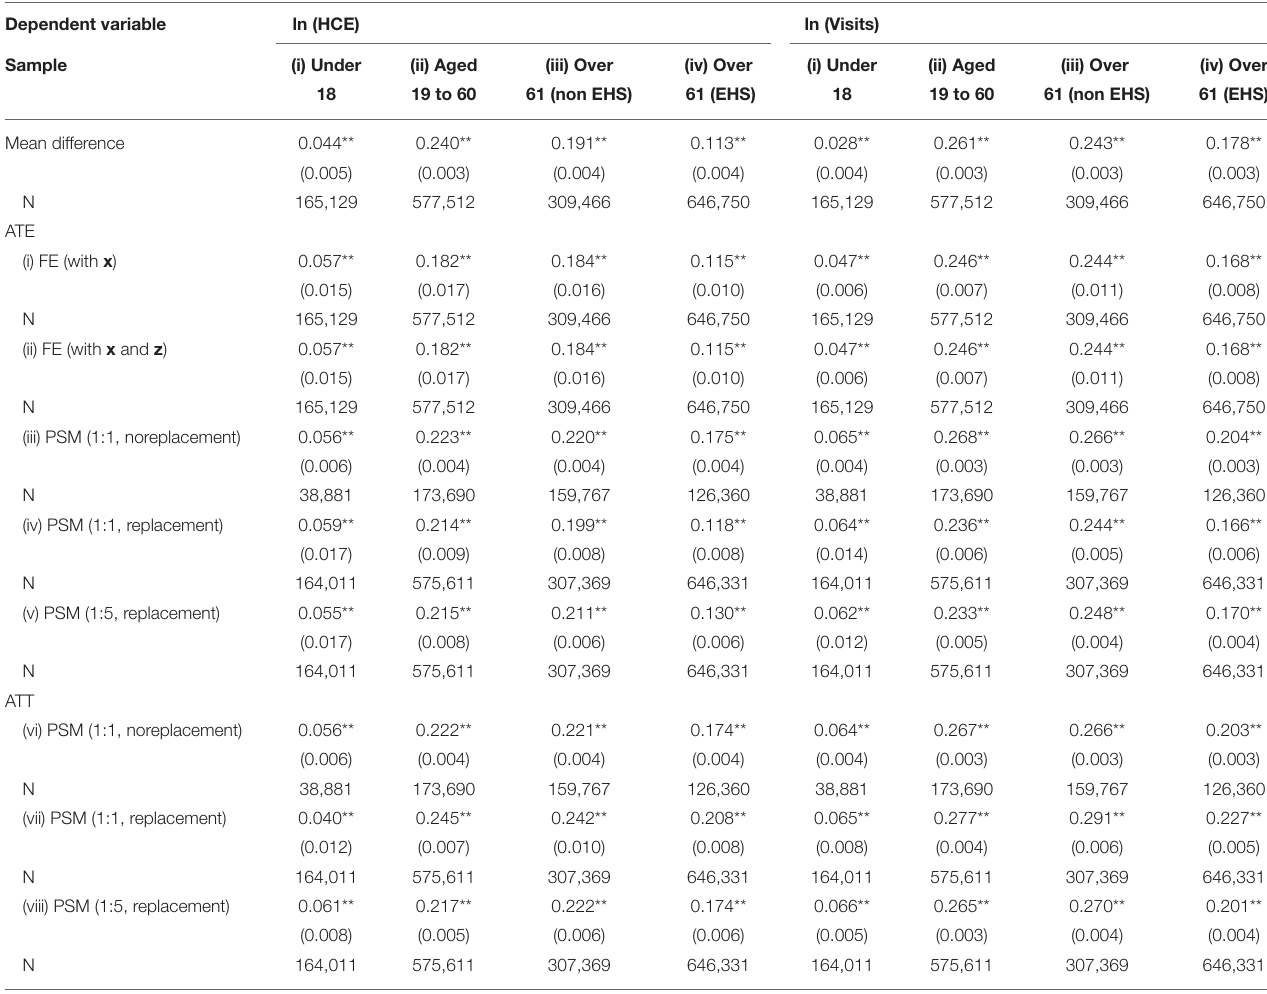
TABLE 4 | Effect of PA assignment on healthcare utilization by age